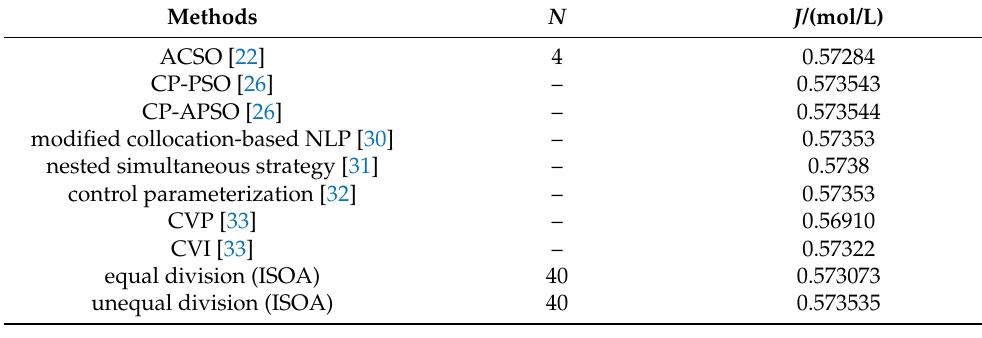
Table 4. Comparison of methods for parallel reaction problems in tubular reactors.